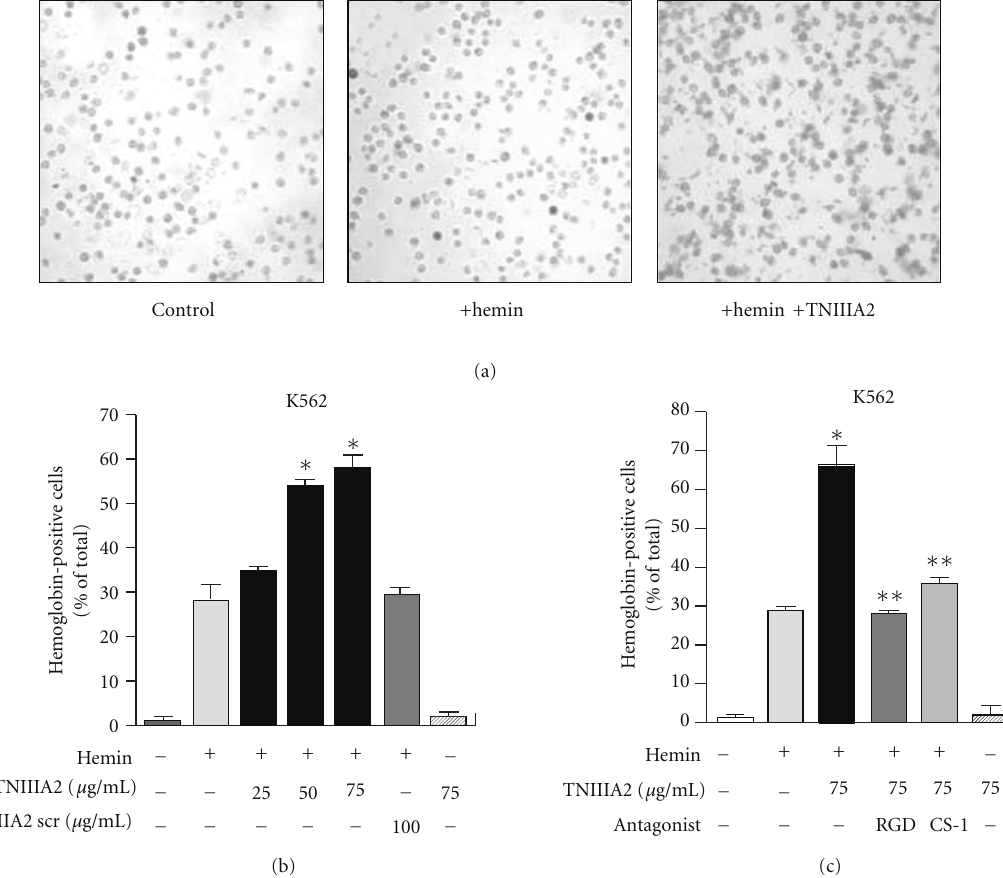
Figure 5: Adhesion dependent acceleration of hemin-induced erythroid di ff erentiation of K562 cells. (a, b) E ff ect of TNIIIA2 on erythroid di ff erentiation of K562 cells, induced by hemin. Typical image of erythroid di ff erentiation was shown in (a). (c) E ff ects of antagonist for VLA5 (RGD) and VLA4 (CS-1) on TNIIIA2-induced acceleration of erythroid di ff erentiation (figures were modified from Figures 2(a), 3(a), and 3(c) of [45]). ∗ P < 0 . 05 versus Hemin single treated sample, ∗∗ P < 0 . 05 versus Hemin and TNIIIA2 treated